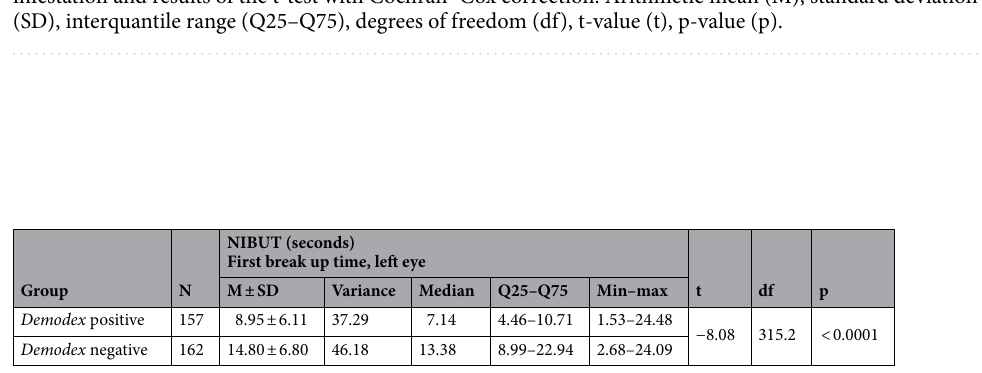
Table 3. Descriptive statistics of the first break up time in the left eye in patients with and without Demodex infestation and results of the t-test with Cochran–Cox correction. Arithmetic mean (M), standard deviation (SD), interquantile Range (Q25–Q75), degrees of freedom (df), t-value (t), p-value (p).